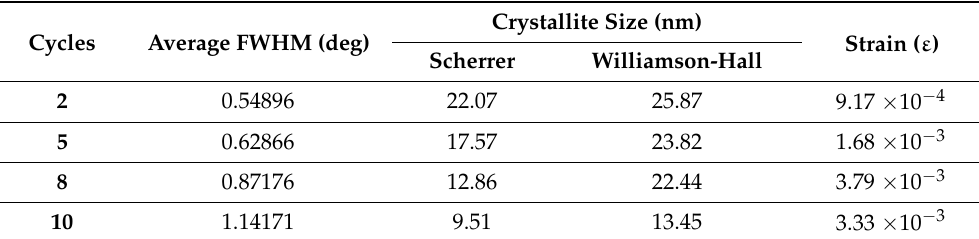
Table 1. ZnO crystallite sizes calculated by the Scherrer and Williamson–Hall (WH) methods, and strain values calculated using the WH